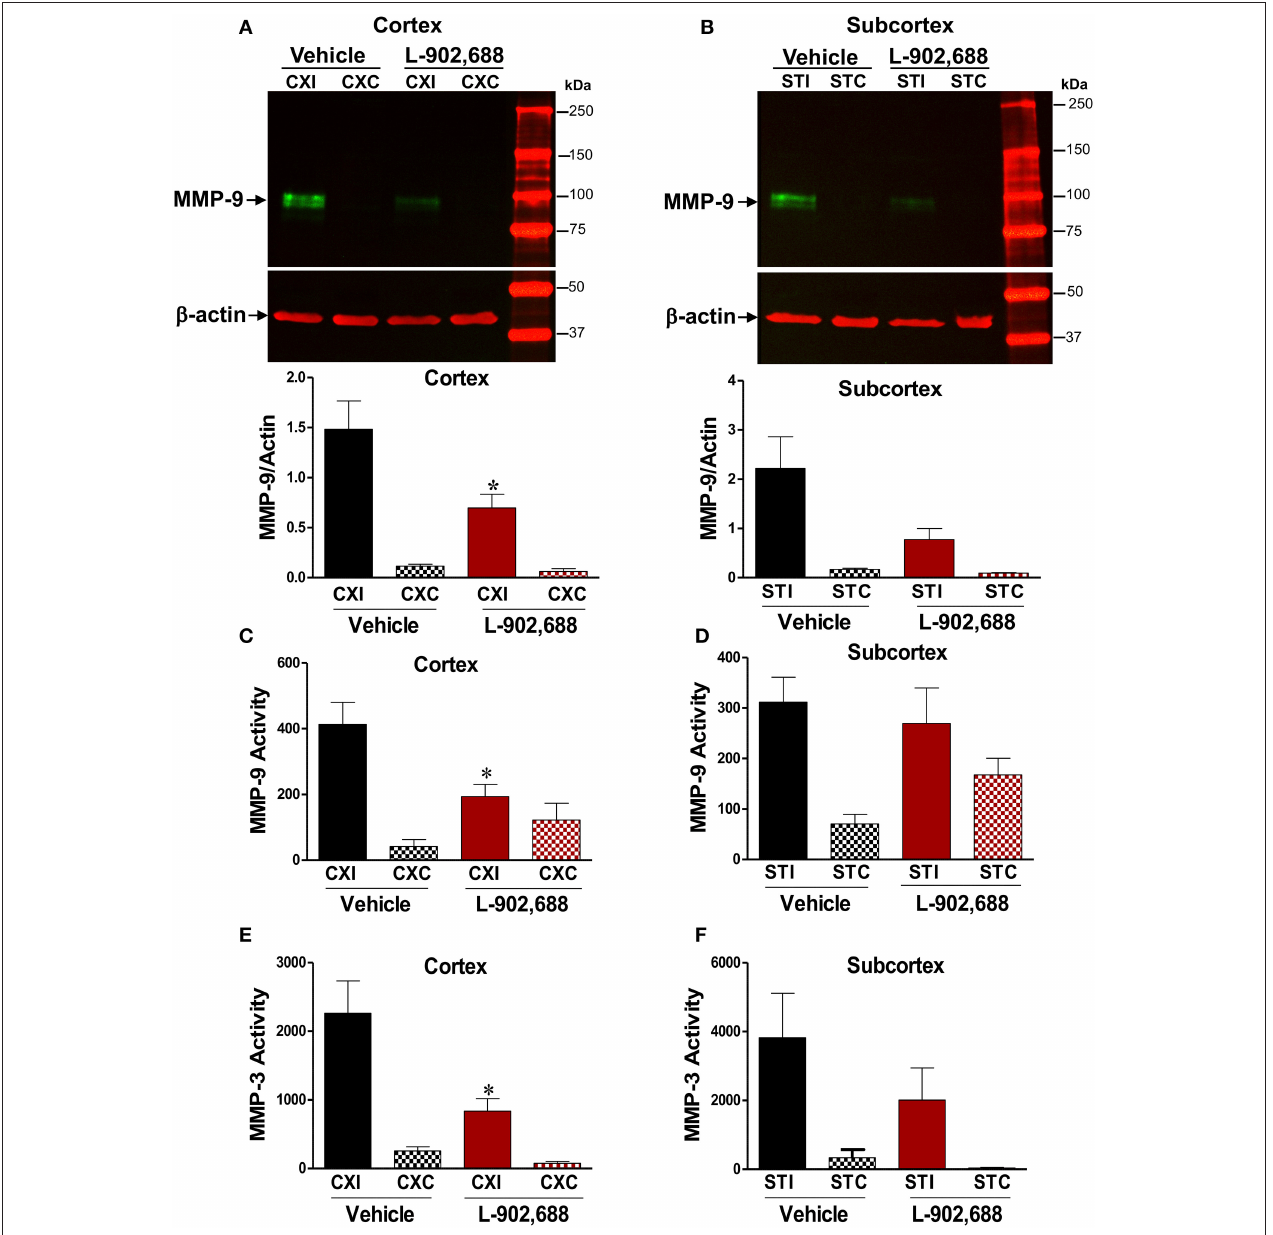
FIGURE 3 | Reduced MMP-9 and MMP-3 Activity in ischemic rats given the EP4 Agonist L-902,688. We measured reduced MMP-9 protein with immunoblotting after 24h of reperfusion in the (A) cortex (* P < 0.05) and (B) the subcortex ( P = 0.0792). There was reduced MMP-9 activity with L-902,688 treatment in the cortex (C) , but not in the subcortex (D). (E) In the cerebral cortex, 1.0 mg/kg L-902,688 significantly reduces MMP-3 activity in the ipsilateral side of the treated group vs. the vehicle group. * P = 0.0215. (F) In the subcortex, the effect of L-902,688 in the ipsilateral hemisphere is less pronounced ( P = 0.1304). CXI, ipsilateral cortex; CXC, contralateral cortex; STI, ipsilateral subcortex; STC, contralateral subcortex. Vehicle ( n = 10) and 1.0 mg/kg L-902,688 ( n =